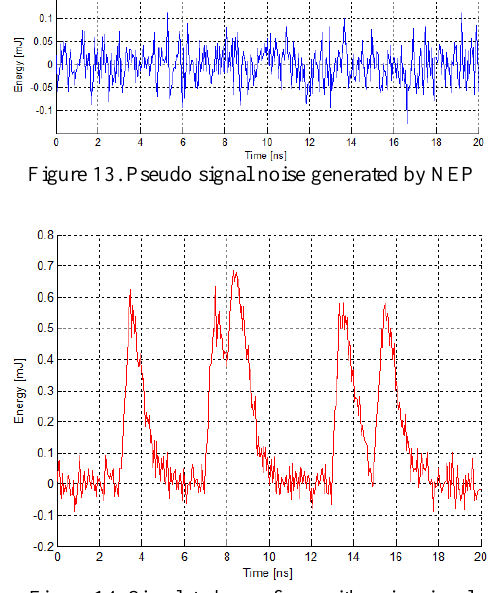
Figure 14. Simulated waveform with noise signal